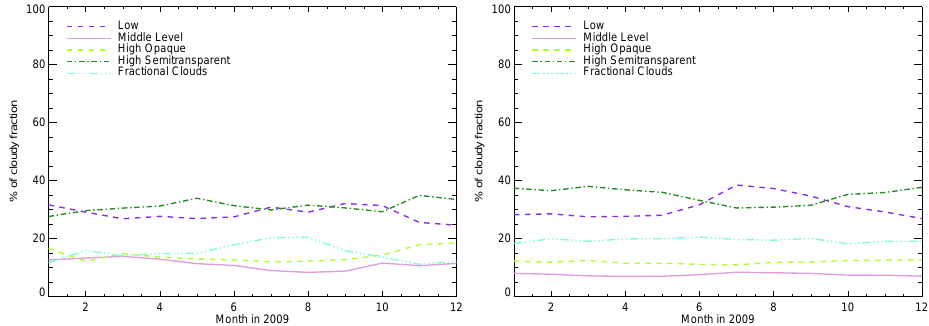
Fig. 3. Averaged proportion of cloud types from the cloudy fraction in 2009 based on monthly mean data; left: Europe; right: SEVIRI disc. and 65.4 gm − 2 ; July: 79.3 gm − 2 , 63.4 gm − 2 ; and October: 108.6 gm − 2 , 79.2 gm − 2 . In Table 3 the average values for